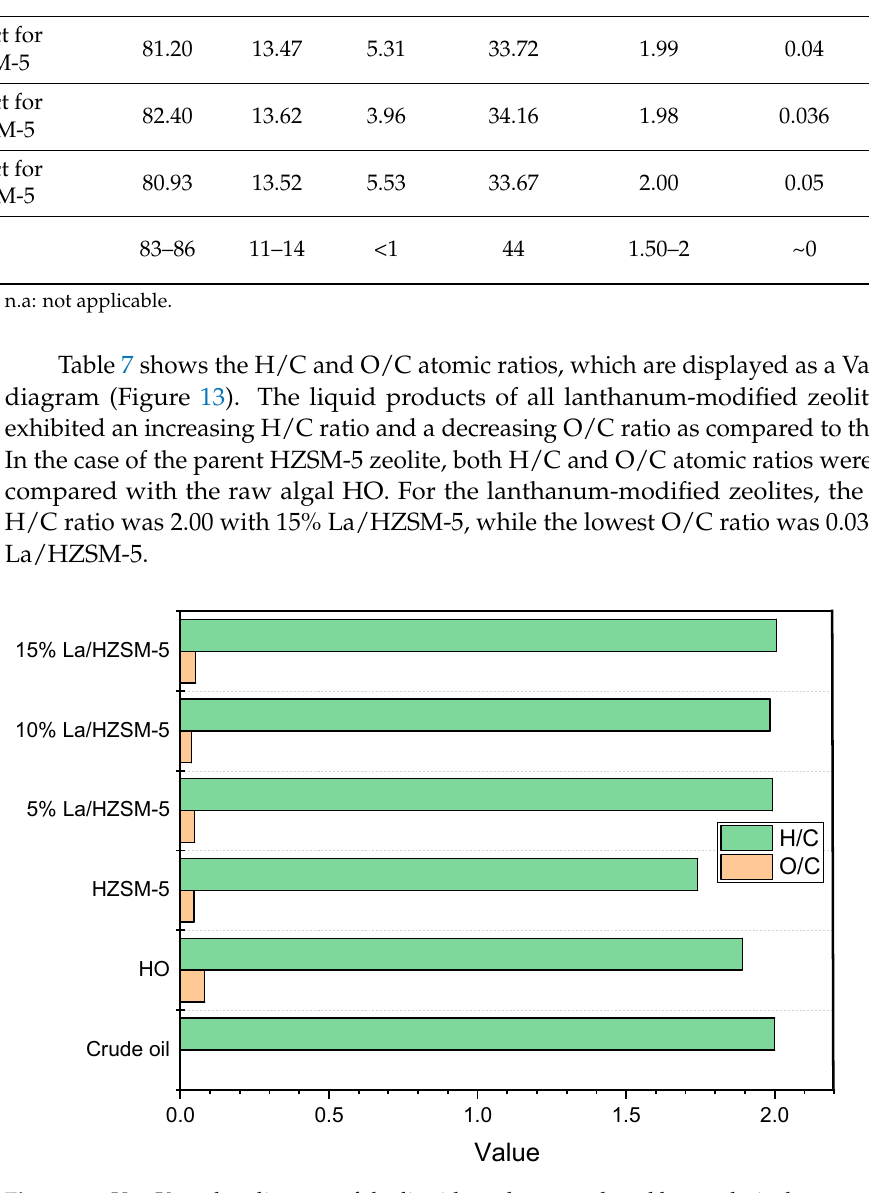
Figure 13. Van Krevelen diagram of the liquid products produced by catalytic deoxygenation of the algal HO over HZSM-5 and lanthanum-modified zeolite catalysts. Table 7. The degree of deoxygenation, elemental composition, higher heating values, H/C, and O/C atomic ratios for the algal HO, and the liquid products of the catalytic deoxygenation over the parent HZSM-5 and lanthanum-modified zeolite catalysts.